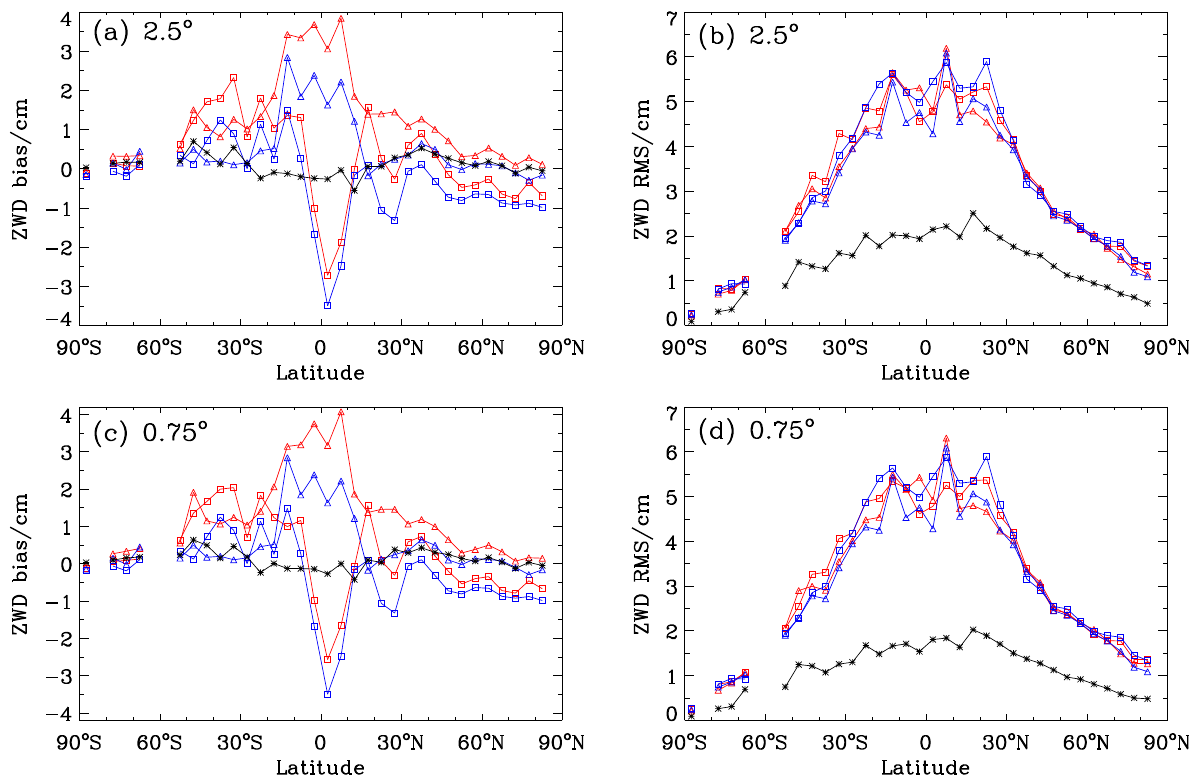
Figure 7. Latitudinal variation of zonal mean (5 ◦ latitude interval) bias ( a , c ) and RMS ( b , d ) values of ZWDs. The reference ZWDs are calculated from radiosonde profiles over 530 IGRA stations. The red triangle refers to results obtained using P , T , and e from ERA surface analysis data with the A&N model, and the red square refers to those with the Saas model. The black asterisk refers to results obtained using P , T , e , and PWV from ERA surface analysis data. The blue triangle refers to results obtained using P , T , and e at the surface level of radiosonde data with the A&N model, and the blue square refers to those with the Saas model.